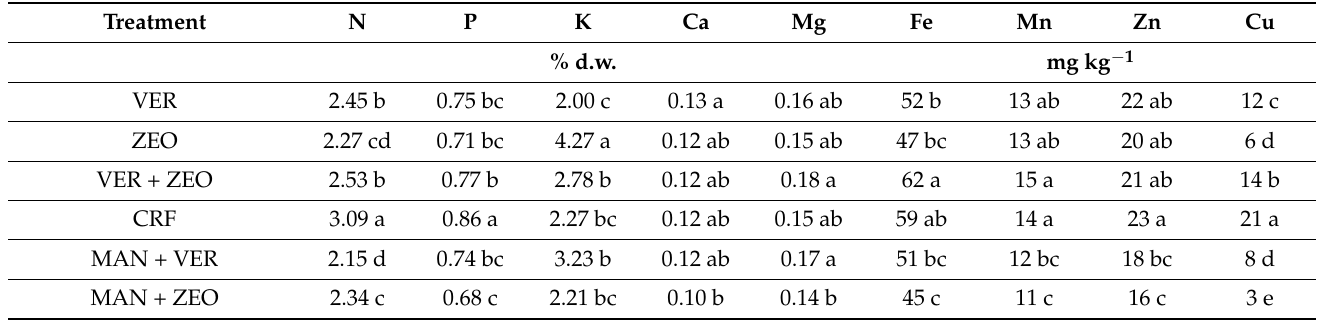
Table 5. Fruit nutrient concentrations in pepper plants among the treatments.